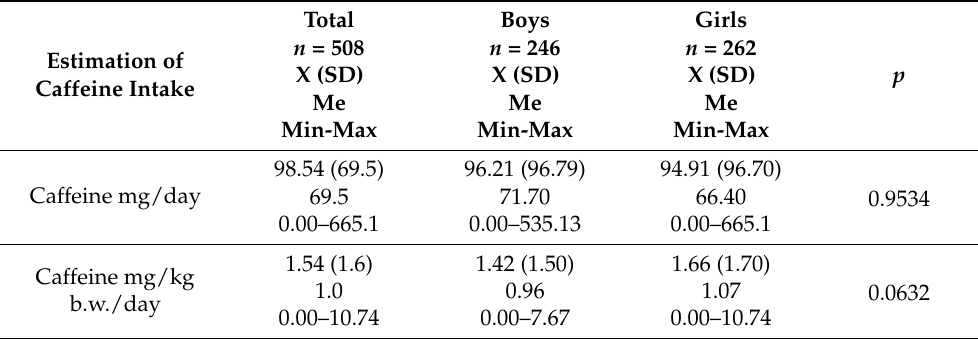
Table 2. Caffeine intake per day (mg) and per body weight (mg/kg b.w.).